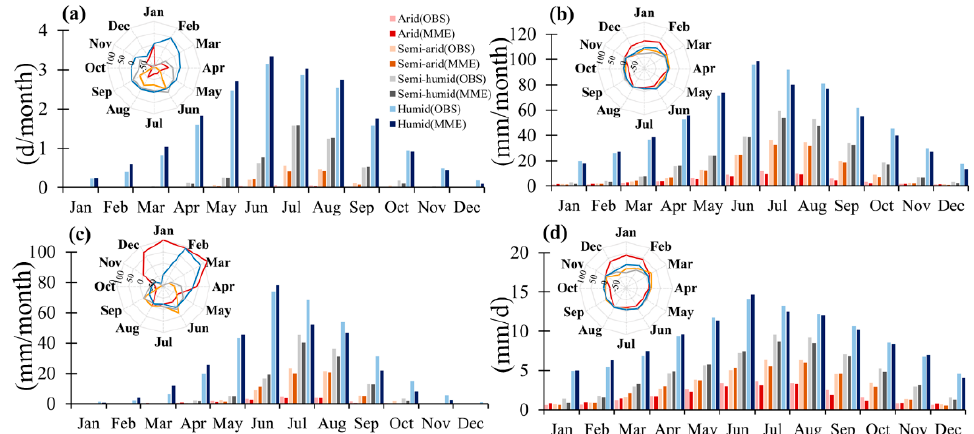
Figure 5. Monthly precipitation indices (( a ) R20: d/month; ( b ) Rx5: mm/month; ( c ) R95p: mm/month; ( d ) SDII: mm/d) of four regions (arid, semi-arid, semi-humid, humid) in China and bias between multi-model ensemble means and observations ((MME–OBS)/OBS; unit: %) in 1961–2005.